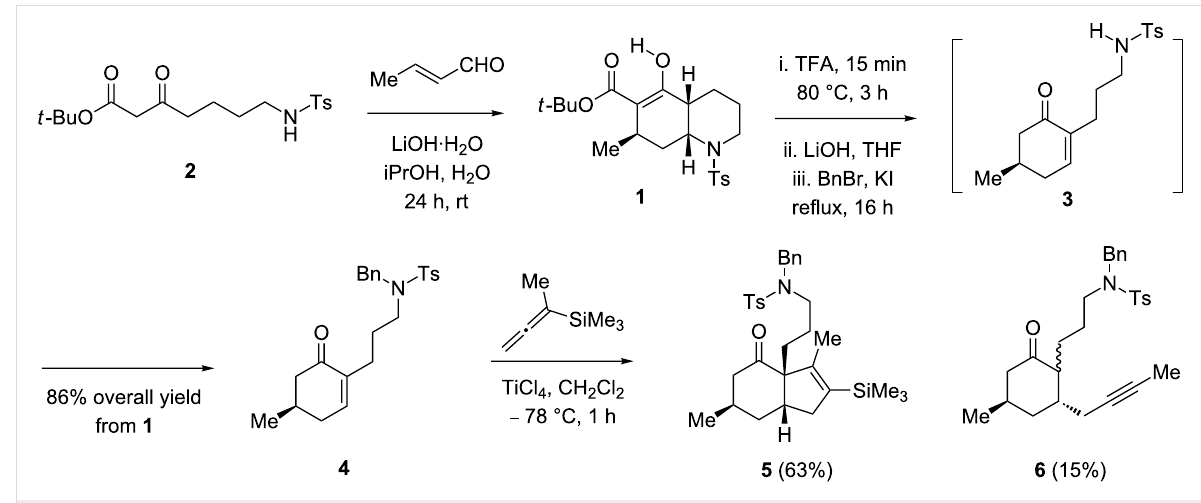
Scheme 3: Synthesis of enone 4 and the Danheiser annulation. The depicted compounds are all racemic.